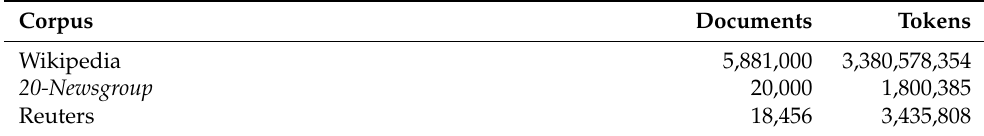
Table 5. Description of dataset.